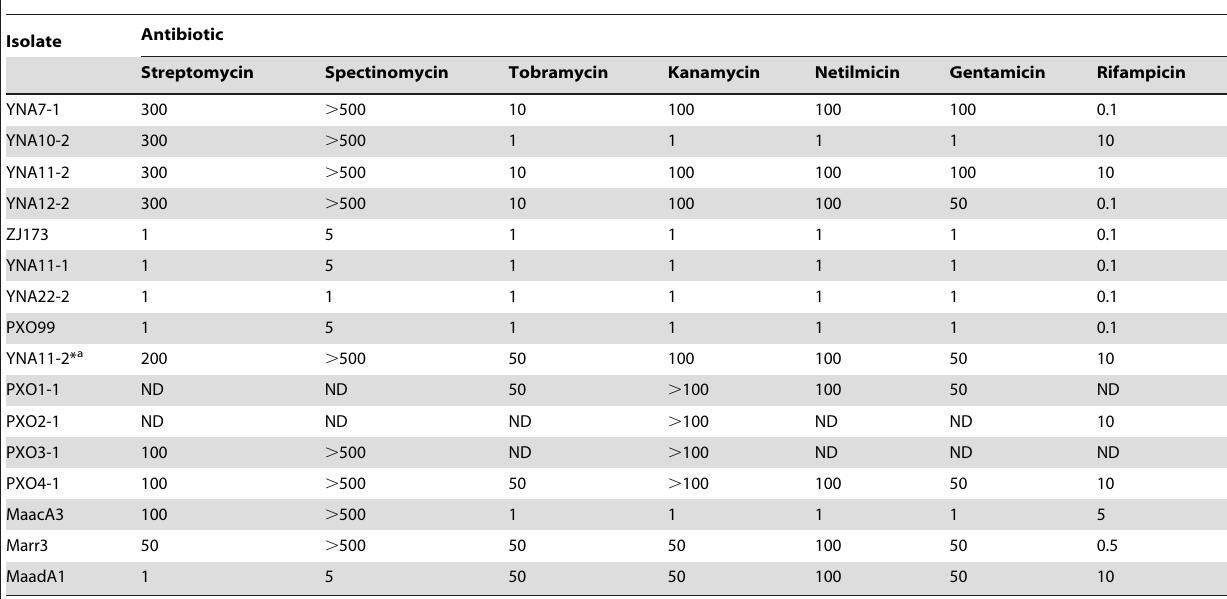
Table 5. The MIC (minimum inhibitory concentration, m g/ml) of X. oryzae pv. oxyzae isolates to diverse antibiotics.